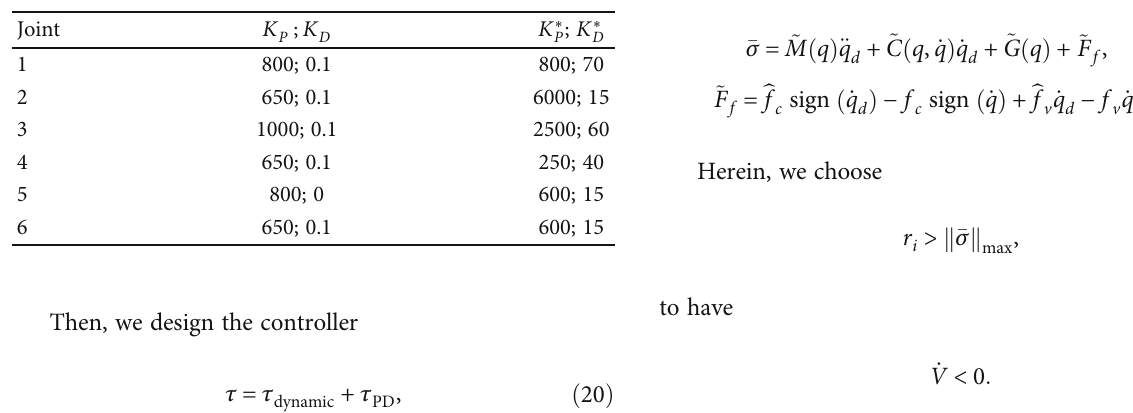
Figure 6: Tracking performance of the 3rd joint and the 6th joint of the robot controlled by variable structure control and PD plus. Table 3: Controller parameters of each